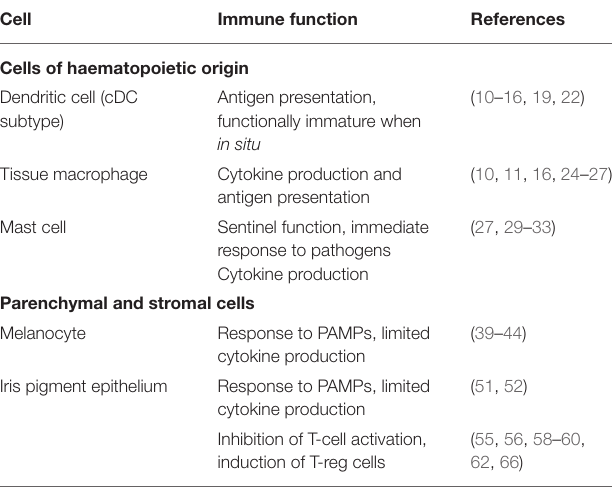
TABLE 1 | Summary table of the immune functions of iris cell types.